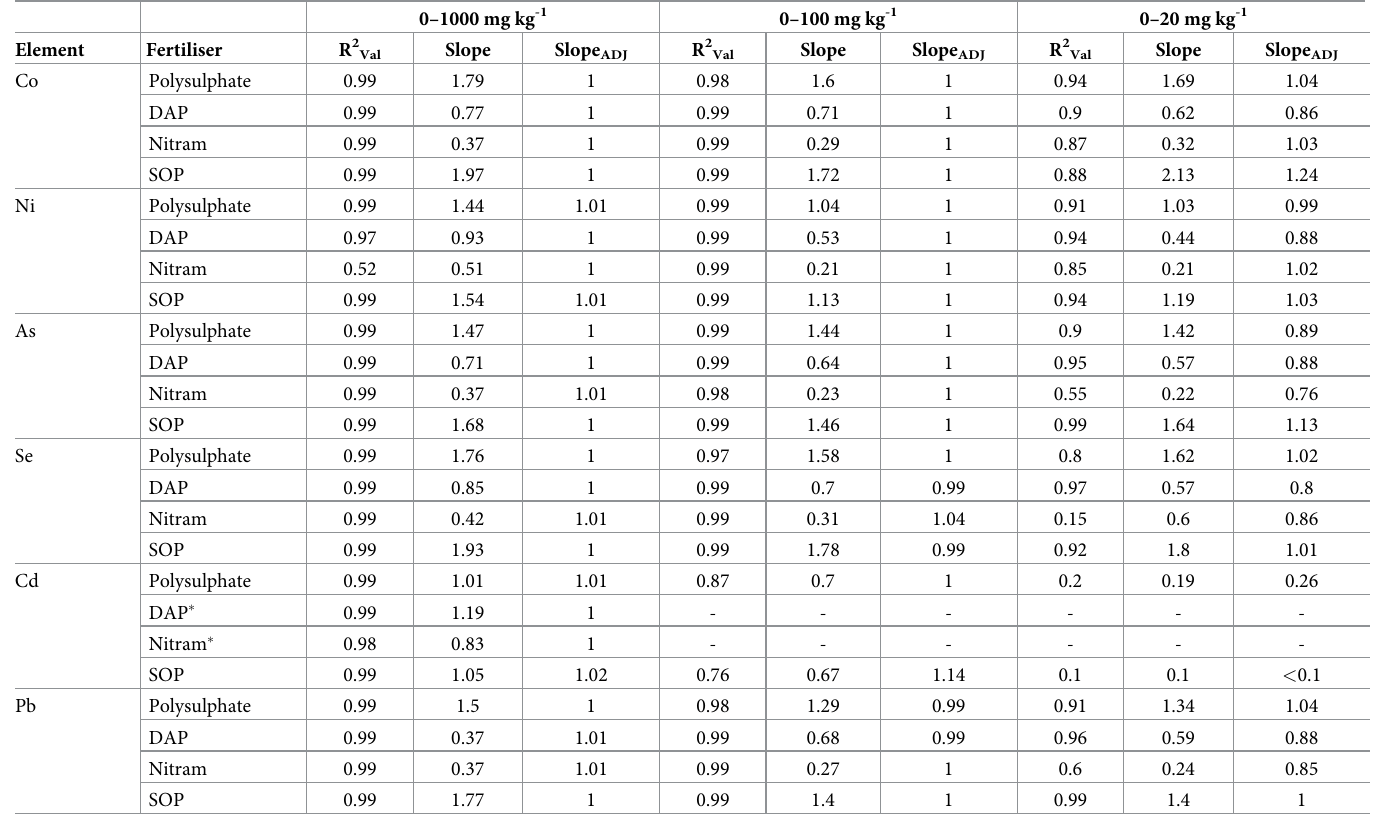
Table 8. Goodness of fit parameters for the validation of the Fertiliser Trace